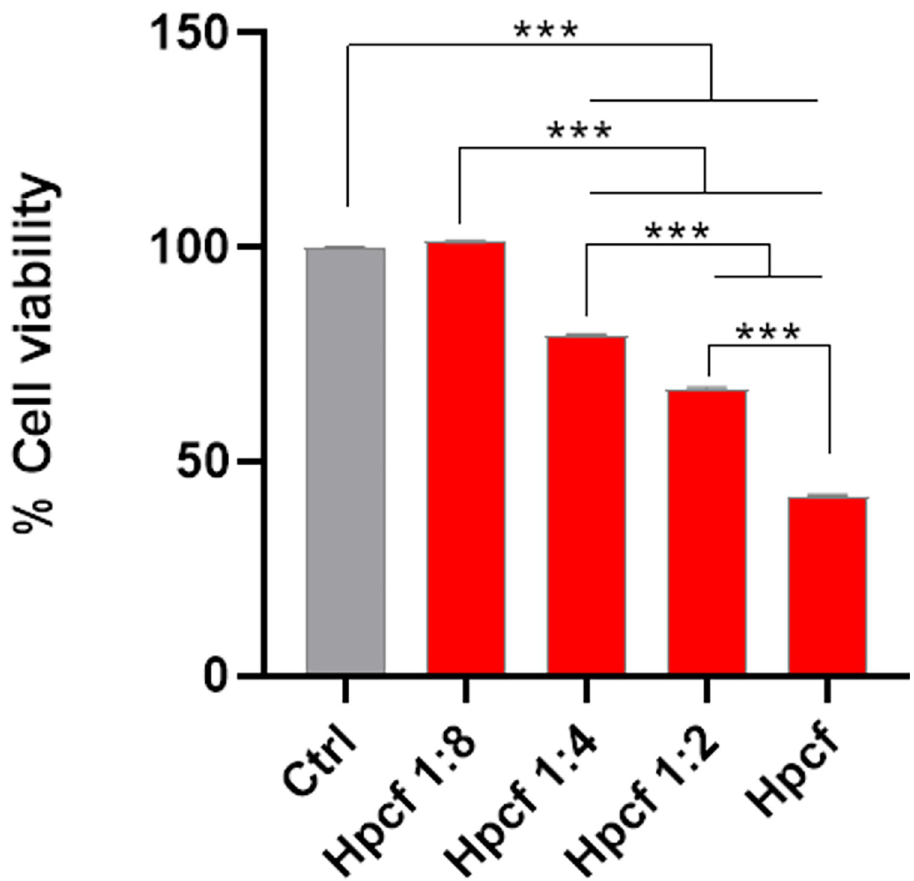
uninoculated broth medium (Hpcf 1:2; Hpcf 1:4; Hpcf 1:8). One-way ANOVA followed by Bonferroni post hoc correction was used to determinate statistically significant differences ( ��� p <